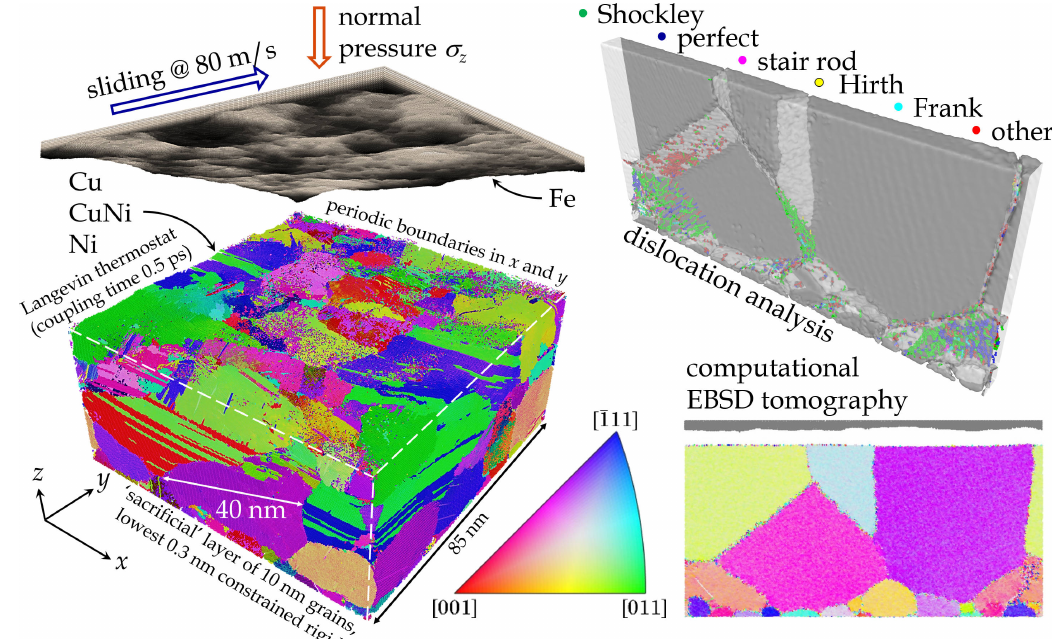
Figure 1. Left : 3D overview of a representative CuNi–Fe tribosystem after sliding, with the interacting bodies separated to yield a clear view of the surface. Different colors in the CuNi base body represent different crystallographic orientations, gray-scales in the Fe counterbody show its topography. Top right : dislocation analysis of a slice of the initial system before sliding begins, colored by type (see legend). Bottom right : corresponding computational electron backscatter diffraction (EBSD) tomograph (inverse pole figure (IPF) coloring, see